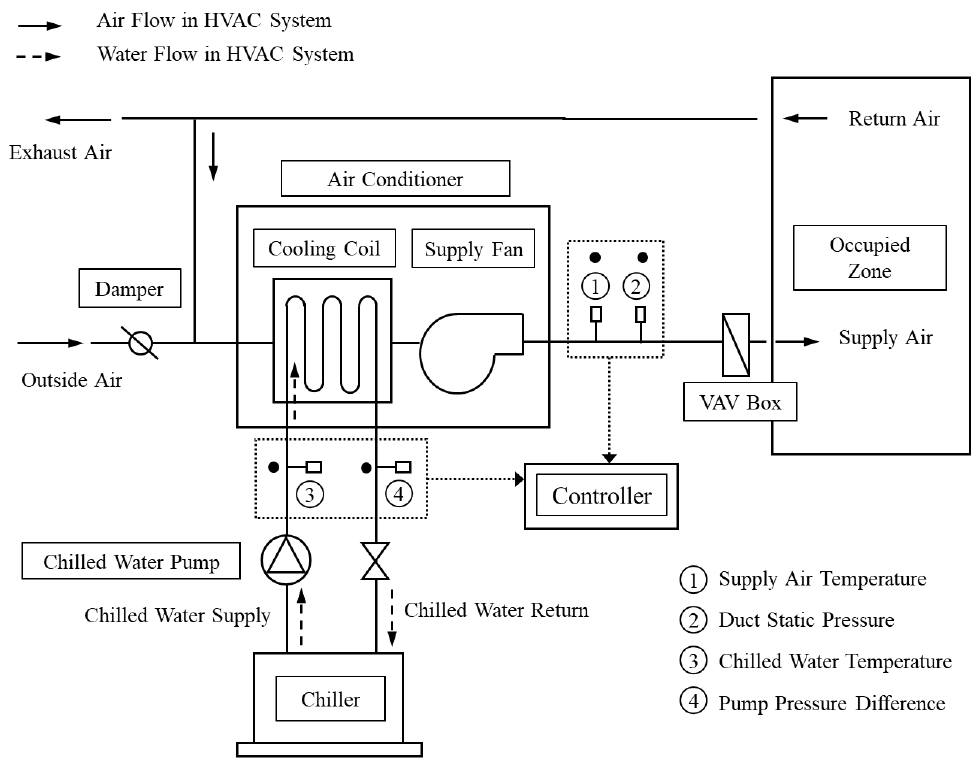
Figure 2. Schematic of a typical HVAC system and control set points.